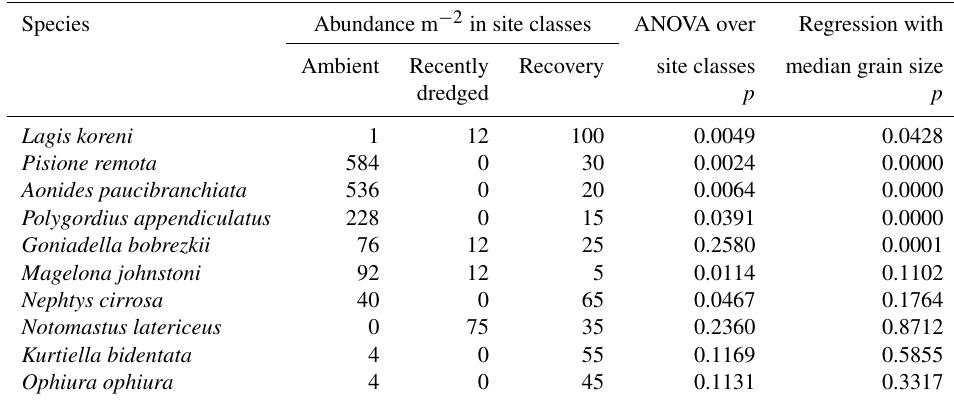
Table 2. Abundance variations in the top 10 species over site classes, with ANOVA significance level and significance level of linear regression of abundance with median grain